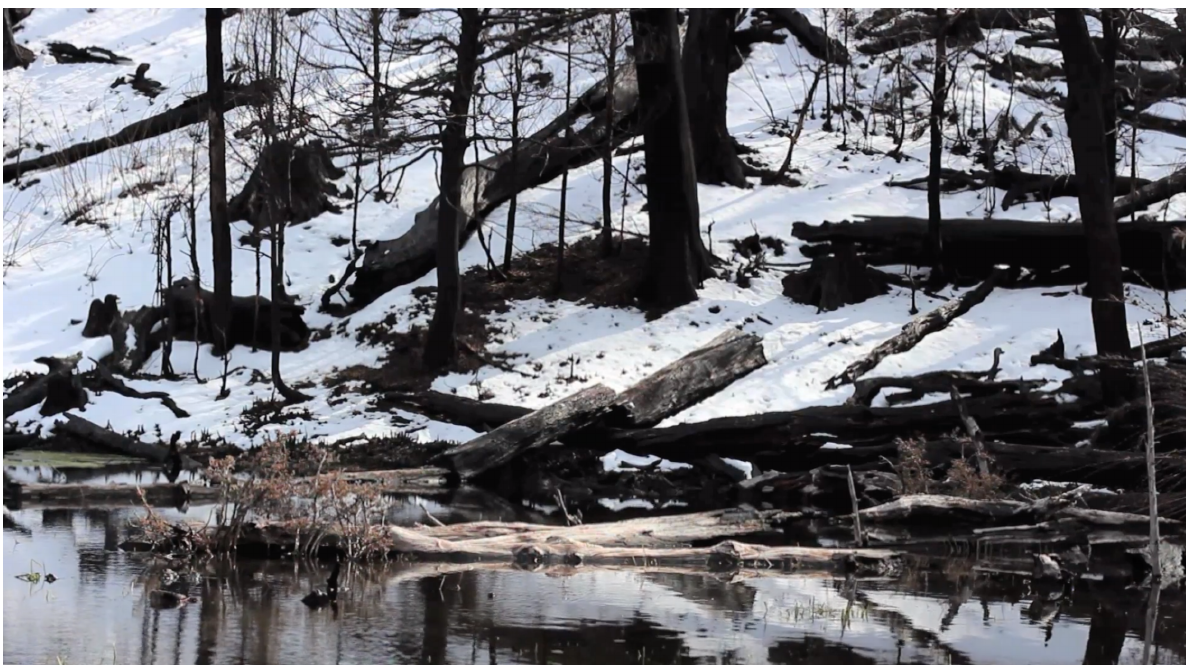
Figure 3: Still from Francisco Huichaqueo Pérez’s Kütral Kürruf Mew - El fuego en el aire (2017) Video still courtesy of Francisco Huichaqueo Pérez. Film available at: https://vimeo.com/